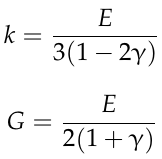
Table 1. Model physical and mechanical parameters.